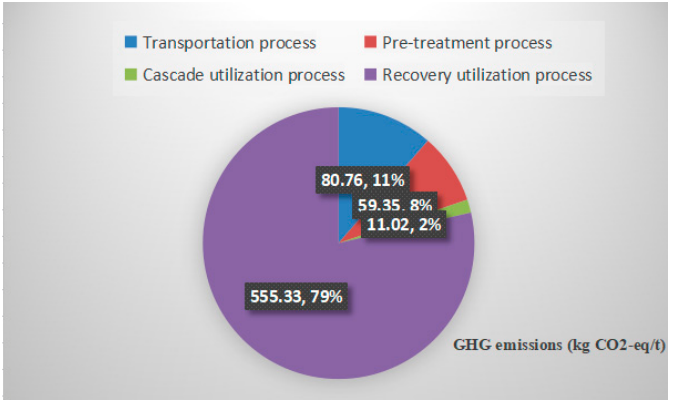
Figure 5. Contribution of different life-cycle stages to total GHG emissions.